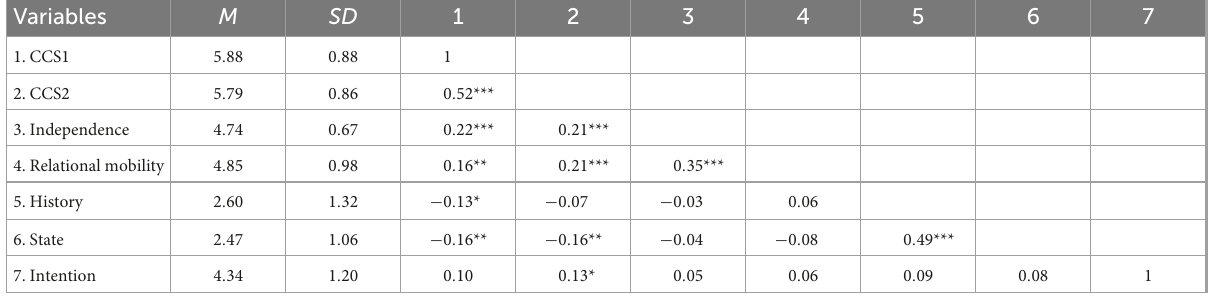
TABLE 1 Descriptive statistical and correlation analysis for each